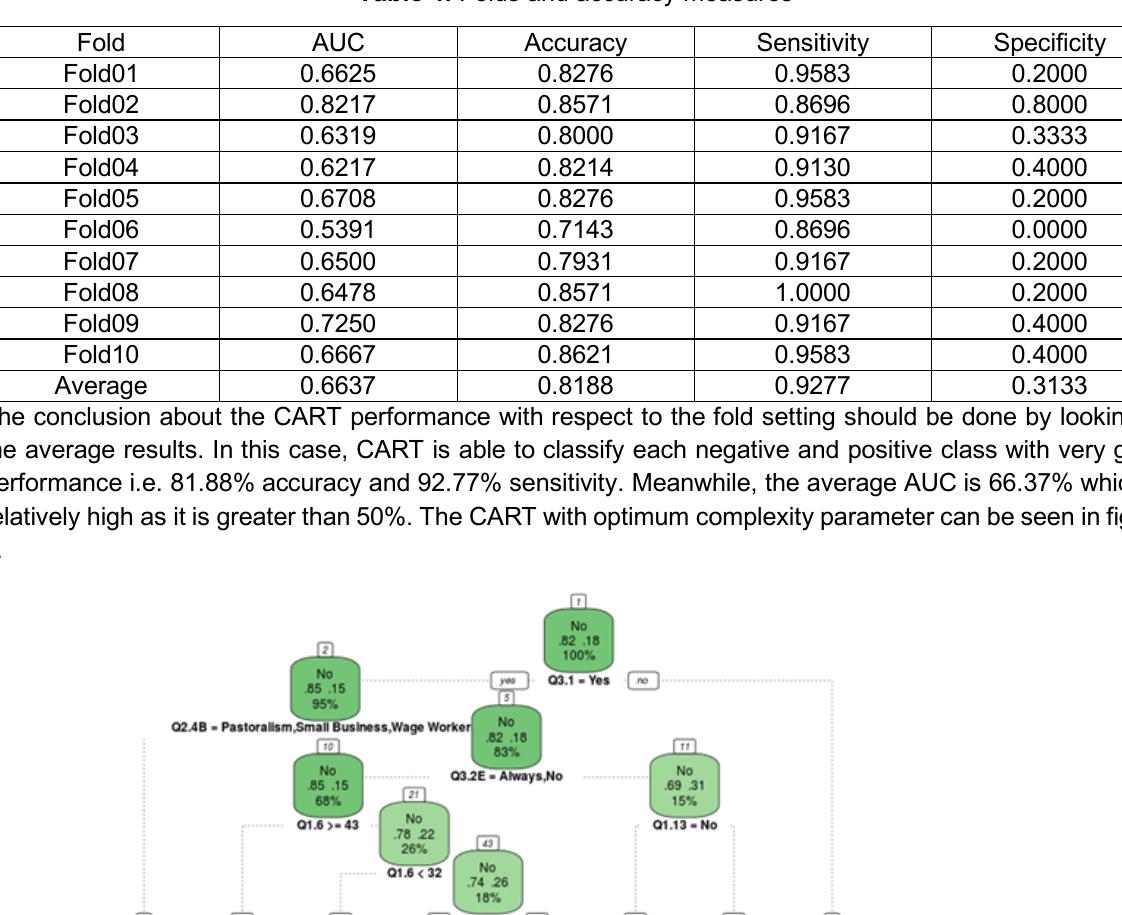
Table 4: Folds and accuracy measures